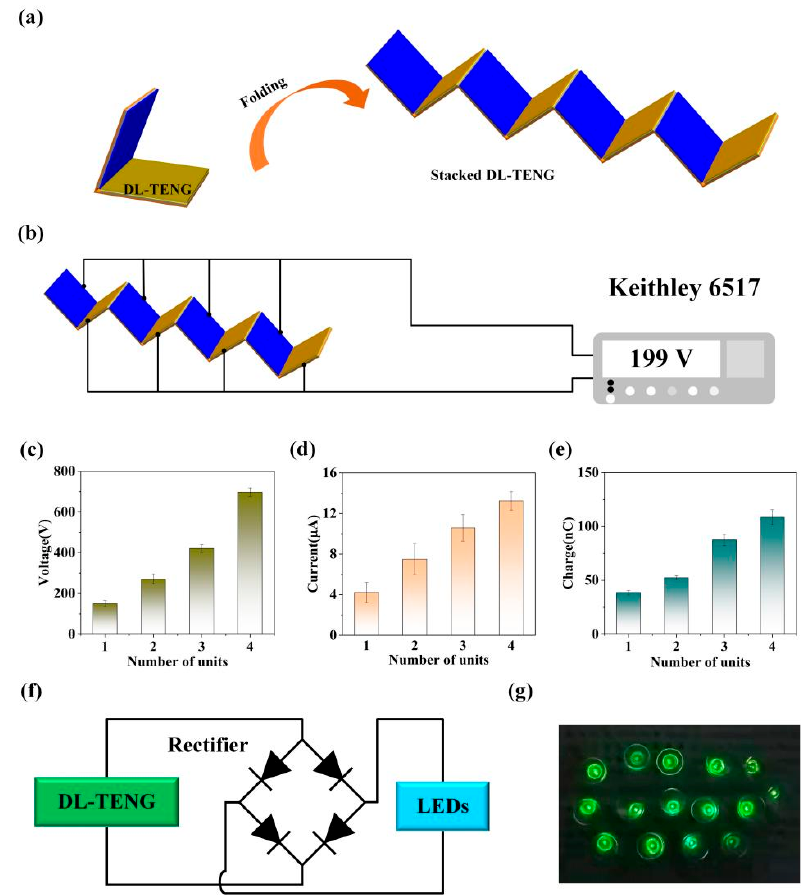
Figure 6. ( a ) The schematic diagram of stacked DL-TENG. ( b ) The schematic diagram of circuit connection for stacked DL-TENG. ( c – e ) The electrical output of DL-TENG with four working units. ( f ) The schematic diagram of power management circuit for driving commercial light-emitting diodes (LEDs). ( g ) Fifteen commercial LEDs driven by the DL-TENG device with four working units.